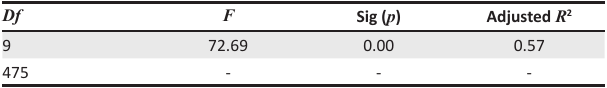
TABLE 7a: Psychological capital subscales and innovative thinking subscales combined model. Df